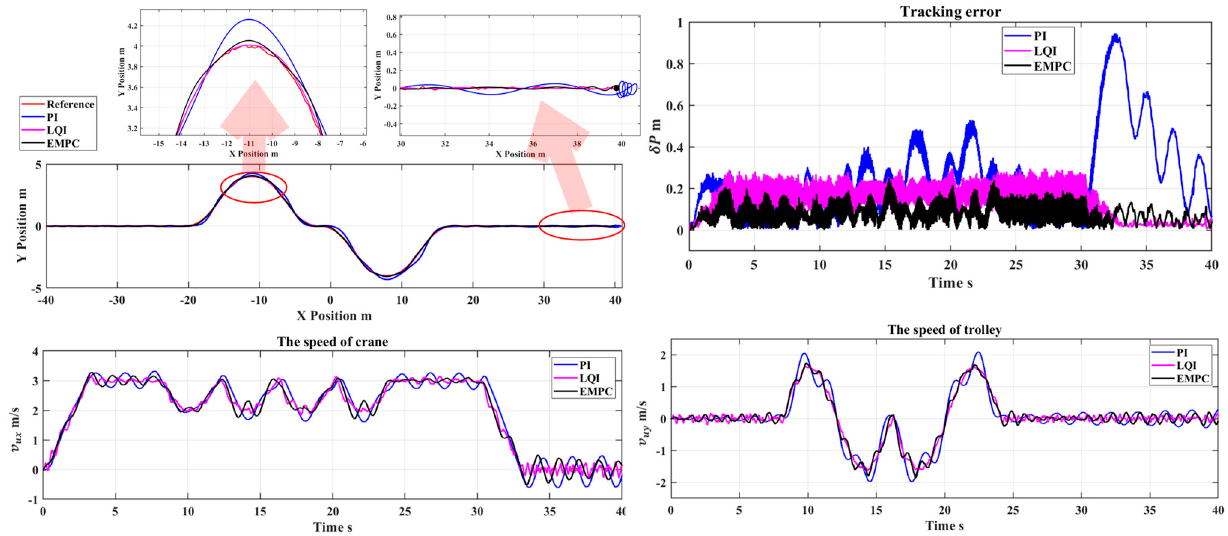
Figure 12. The results of tracking desired path four by the crane and trolley are presented. The figures illustrate the following outcomes: a comparison between the trajectory of the upper lifting point and the expected trajectory under three di ff erent controllers, the tracking error 𝛿𝑃 = (cid:3495)𝛿𝑃 (cid:3051)(cid:2870) + 𝛿𝑃 (cid:3052)(cid:2870) of the track-following servo subsystem, and the movement speed of both the crane and trolley.